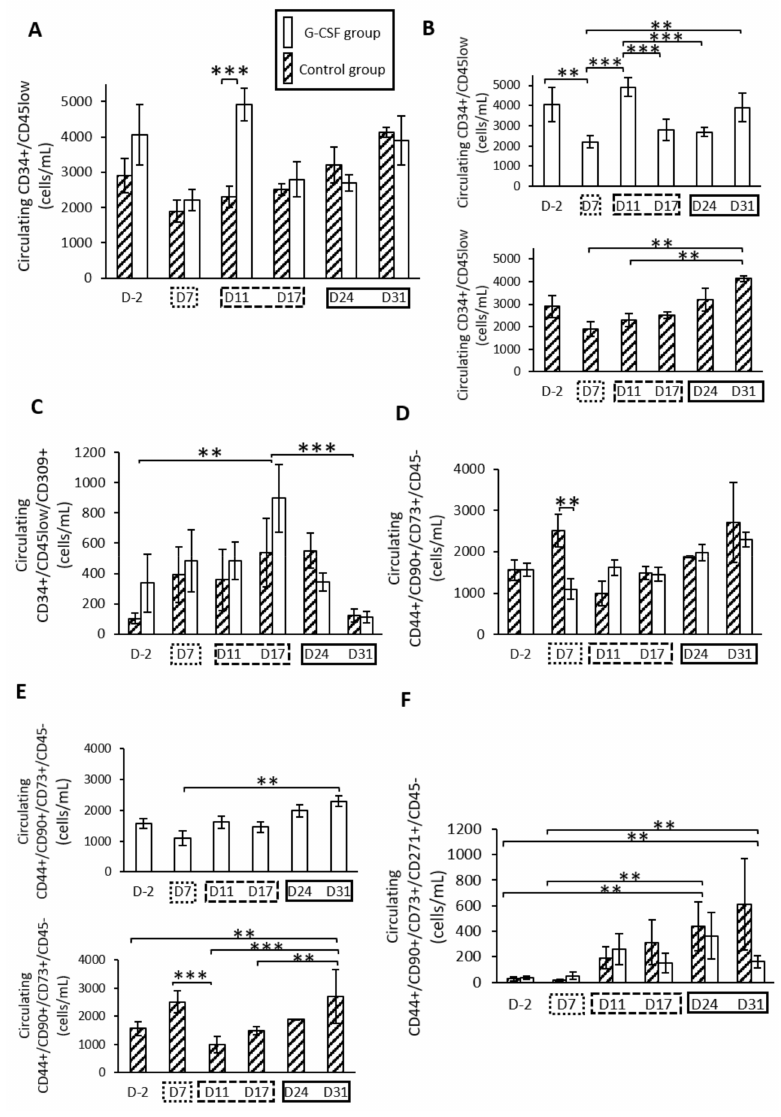
Figure 1. Mobilization of hematopoietic stem/progenitor cells (HSPCs) ( A , B ), endothelial progenitor Figure 3. Course of vascularization metabolism during distraction osteogenesis (DO). ( A ) Repre- Figure 3. Course of vascularization metabolism during distraction osteogenesis (DO). ( A ) Repre- cells (EPCs) ( C ) and mesenchymal stromal cells (MSCs) ( D – F ) during the three phases of distraction sentative positron emission tomography (PET) imaging 7, 17, 20, 24, 38, 52 and 66 days after sur- sentative positron emission tomography (PET) imaging 7, 17, 20, 24, 38, 52 and 66 days after sur- Figure 3. Course of vascularization metabolism during distraction osteogenesis (DO). ( A ) Repre- osteogenesis. ( A ) A significant peak of HSPC concentration at D11 for the granulocyte colony- gery. ( B ) The temporal pattern of the mean uptake ratio of [ 68 Ga]-RGD is presented and demon- gery. ( B ) The temporal pattern of the mean uptake ratio of [ 68 Ga]-RGD is presented and demon- sentative positron emission tomography (PET) imaging 7, 17, 20, 24, 38, 52 and 66 days after sur- stimulating factor (G-CSF) group compared to the control group. ( B ) Representation of intragroup strates vascular metabolism inside the new regenerate. The dotted line represents the control strates vascular metabolism inside the new regenerate. The dotted line represents the control gery. ( B ) The temporal pattern of the mean uptake ratio of [ 68 Ga]-RGD is presented and demon- mobilization patterns of HSPCs. ( C ) For EPC count, only an effect of time is observed, with a group and the filled line represents the G-CSF group. ( C ) In the G-CSF group, the mean ratio group and the filled line represents the G-CSF group. ( C ) In the G-CSF group, the mean ratio strates vascular metabolism inside the new regenerate. The dotted line represents the control significant peak at D17. ( D ) A statistical difference in the mobilization pattern of total MSCs at an peaks at D20 compared to D7 ( p = 0,007) and drops significantly at the end ( p = 0.0001). ( D ) In the peaks at D20 compared to D7 ( p = 0,007) and drops significantly at the end ( p = 0.0001). ( D ) In the group and the filled line represents the G-CSF group. ( C ) In the G-CSF group, the mean ratio early time point (D7). ( E ) Intragroup kinetic pattern for MSC population. A marked augmentation control group, a peak at D20 is also shown compared to D7 ( p = 0.003) but only there is only a drop control group, a peak at D20 is also shown compared to D7 ( p = 0.003) but only there is only a drop peaks at D20 compared to D7 ( p = 0,007) and drops significantly at the end ( p = 0.0001). ( D ) In the of MSCs in the blood stream at 31 days post-surgery is effective for both groups. ( F ) For MSC-271+ at D24 compared to D20 ( p = 0.05). A PET study was performed on 6 control animals and 4 G-CSF at D24 compared to D20 ( p = 0.05). A PET study was performed on 6 control animals and 4 G-CSF control group, a peak at D20 is also shown compared to D7 ( p = 0.003) but only there is only a drop cells, a statistical time effect is seen for later times (D24 and D31) compared to early time points. animals. a, b, c: if two means share the same letter, no statistical differences were found. rep- animals. a, b, c: if two means share the same letter, no statistical differences were found. rep- at D24 compared to D20 ( p = 0.05). A PET study was performed on 6 control animals and 4 G-CSF resent the latency period, the distraction phase is represented by , and the consolidation resent the latency period, the distraction phase is represented by , and the consolidation animals. a, b, c: if two means share the same letter, no statistical differences were found. rep- represents the latency period, the distraction phase is represented by phase. ** p < 0.05, *** p < 0.01, **** p < 0.001, ***** p < 0.0001. phase. ** p < 0.05, *** p < 0.01, **** p < 0.001, ***** p < 0.0001. resent the latency period, the distraction phase is represented by , and the consolidation consolidation phase. ** p < 0.05, *** p < 0.01. Cytometry assays were performed on 6 G-CSF animals phase. ** p < 0.05, *** p < 0.01, **** p < 0.001, ***** p < 0.0001. and 4 control